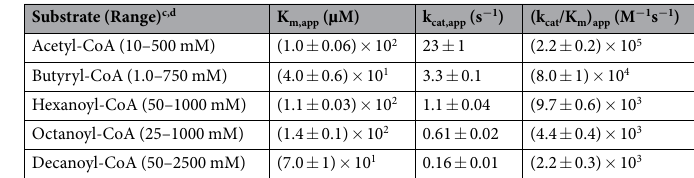
Table 2. Steady-state Kinetic Constants for Acyl-CoA Substrates at a Fixed Initial Concentration of Agmatine a,b . a Kinetic constants are reported as ± standard error (n = 3). b Reaction conditions − 300 mM